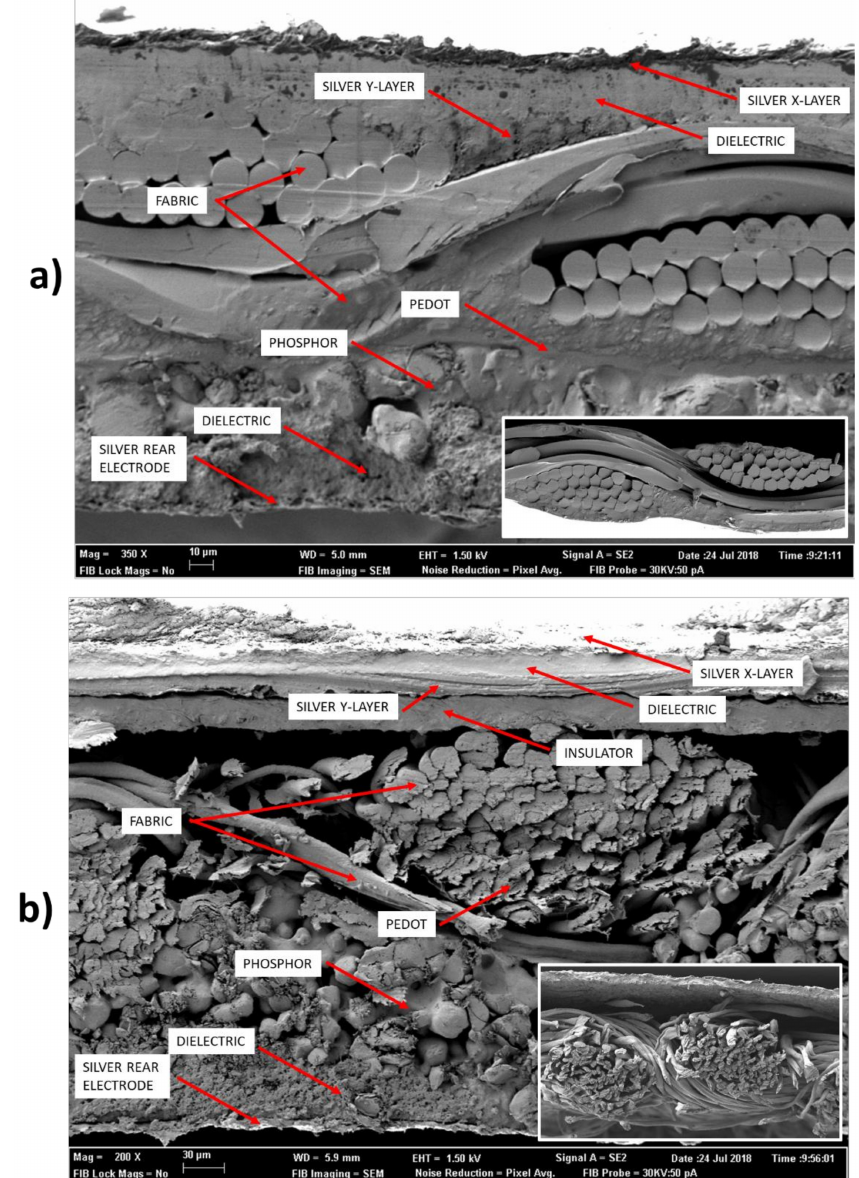
Figure 5. SEM micrograph showing device cross-section. Fabric_A ( a ) and Fabric_C ( b ). In a box, in the bottom right corner of each figure, the virgin fabric is